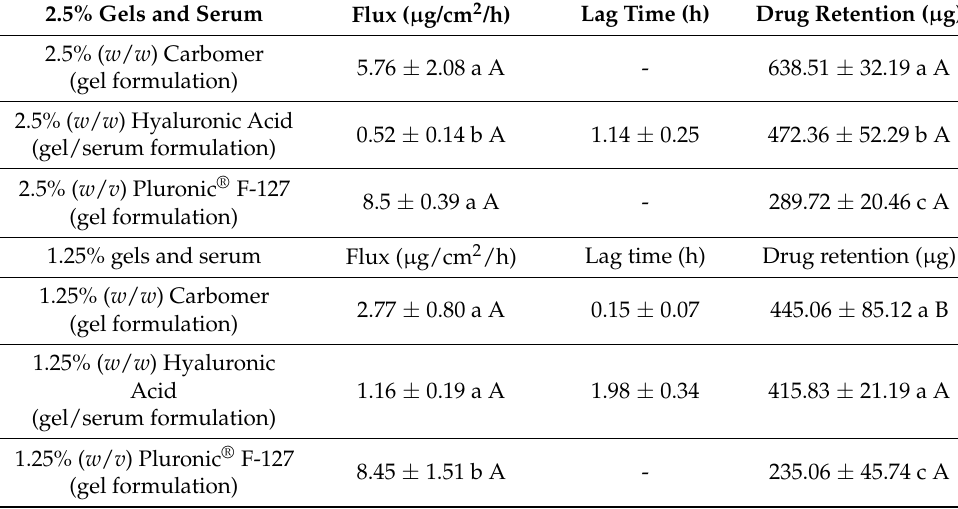
Table 4. In vitro drug membrane parameters of resatorvid topical gels/serum formulations through Strat-M ® transdermal diffusion membrane ( n = 3, mean ± standard deviation). Lowercase letters indicate differences between formulations with the same concentration. Capital letters indicate differences between concentrations in the same formulation ( p <